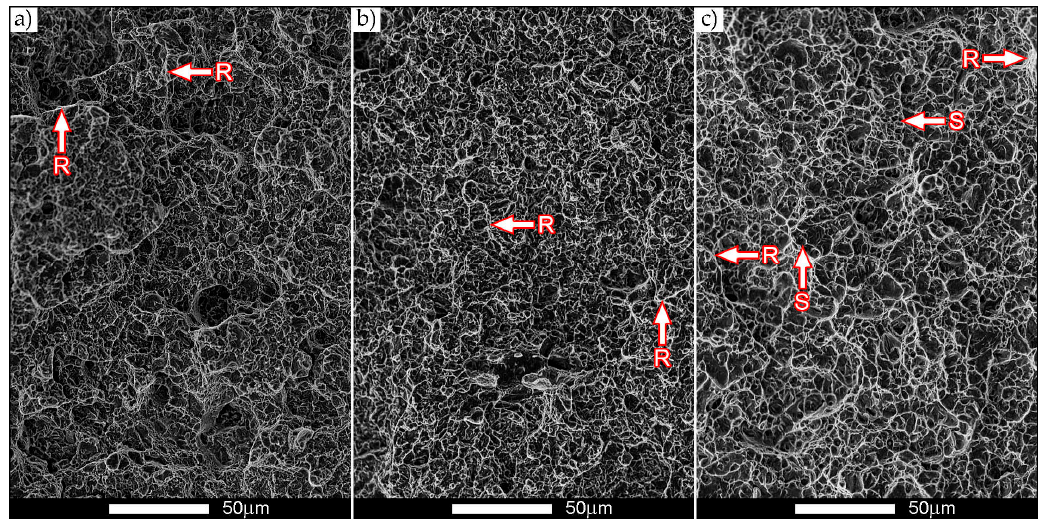
Figure 28. SEM images of fracture surfaces of Hardox Extreme welded joints after heat treatment, shown in Figure 24, after impact testing at − 40 ° C. ( a ) Area marked with the frame A4; ( b ) area marked with the frame B4; ( c ) area marked with the frame C4. R—“river” system; C—microcracks with fine steps; S—“scaly” steps. Scanning microscopy, unetched.